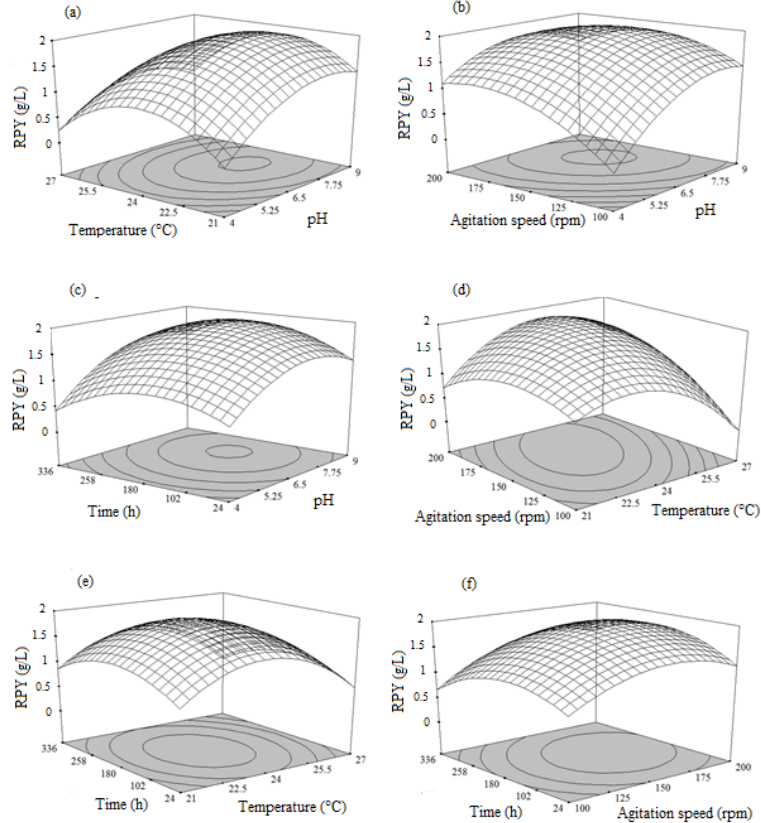
Figure 2. Response surface plots showing the influence of the process variables on the red pigment yield (RPY): ( a ) Interaction between temperature and pH; ( b ) Interaction between agitation speed and pH; ( c ) Interaction between time and pH; ( d ) Interaction between agitation speed and temperature; ( e ) Interaction between time and temperature; ( f ) Interaction between time and agitation speed.